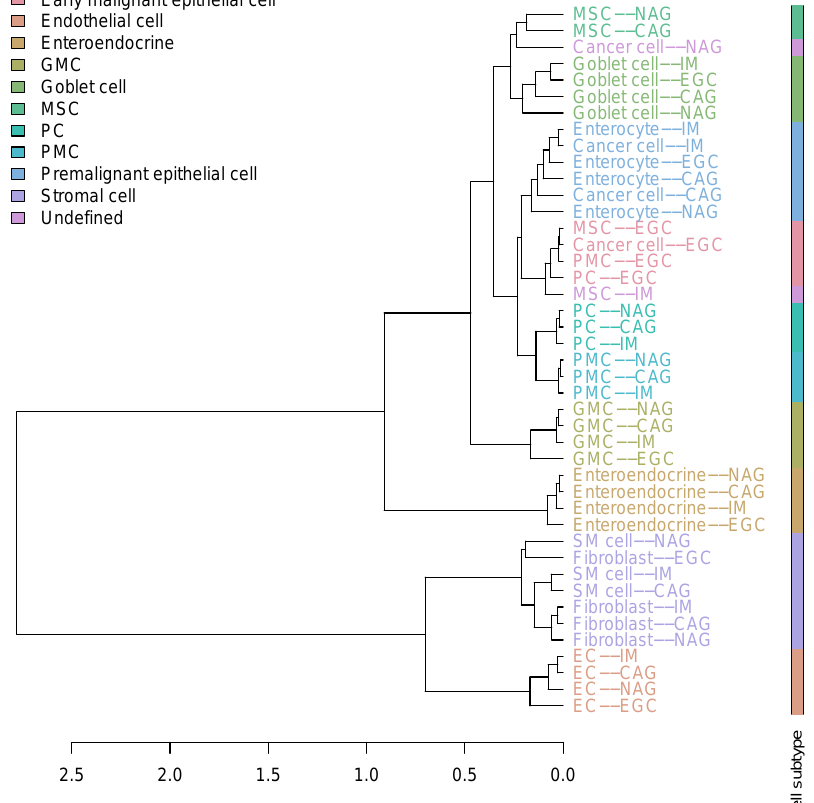
Figure 1. Cluster tree of 11 non-immune cell types of patients with NAG, CAG, IM, and EGC (top 100 genes).